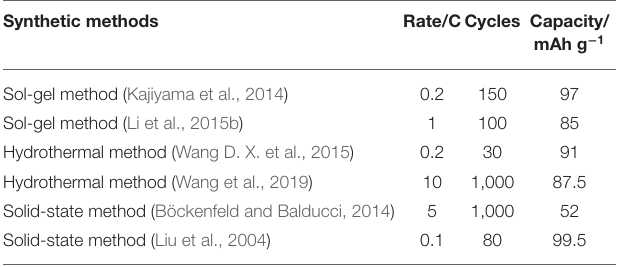
TABLE 1 | Electrochemical performances of NVP prepared by different